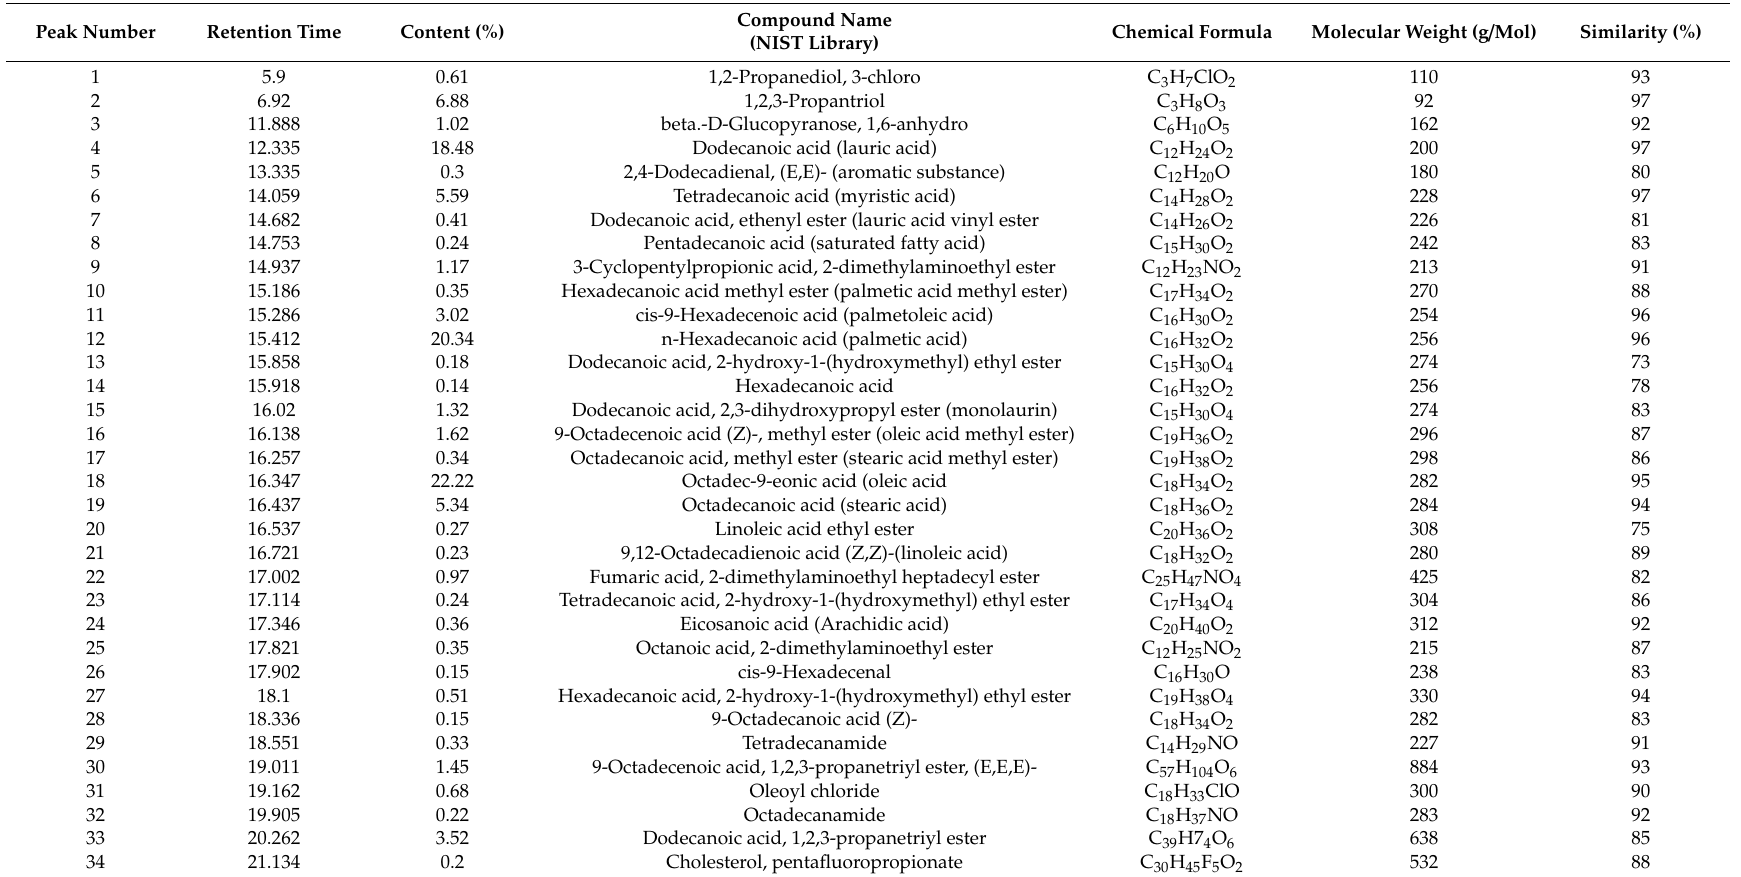
Table 4. Chemical content of AWME from BSFL